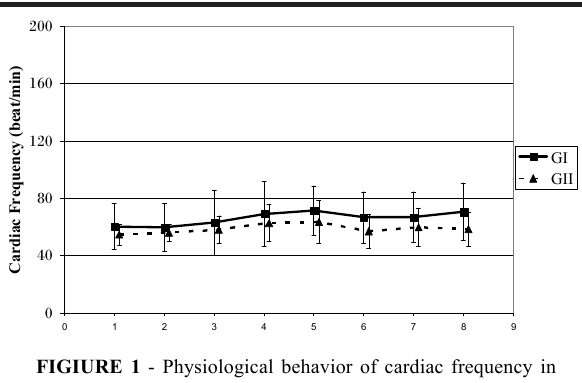
FIGIURE 1 - Physiological behavior of cardiac frequency in groups G1 and G2.